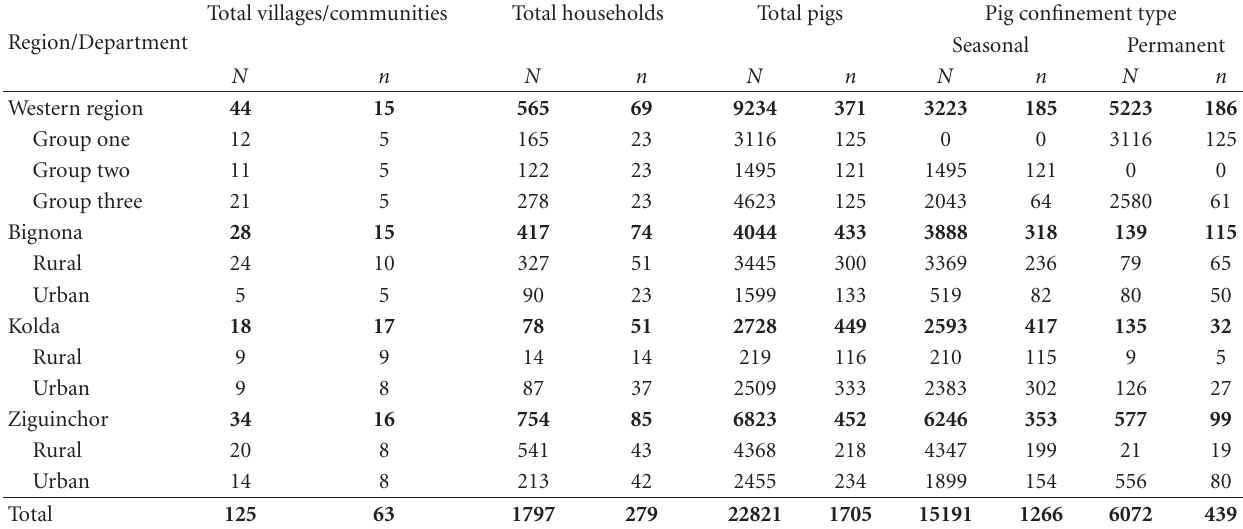
Table 1: Pig population ( N ) and sample size ( n ) of the four study areas in The Gambia and